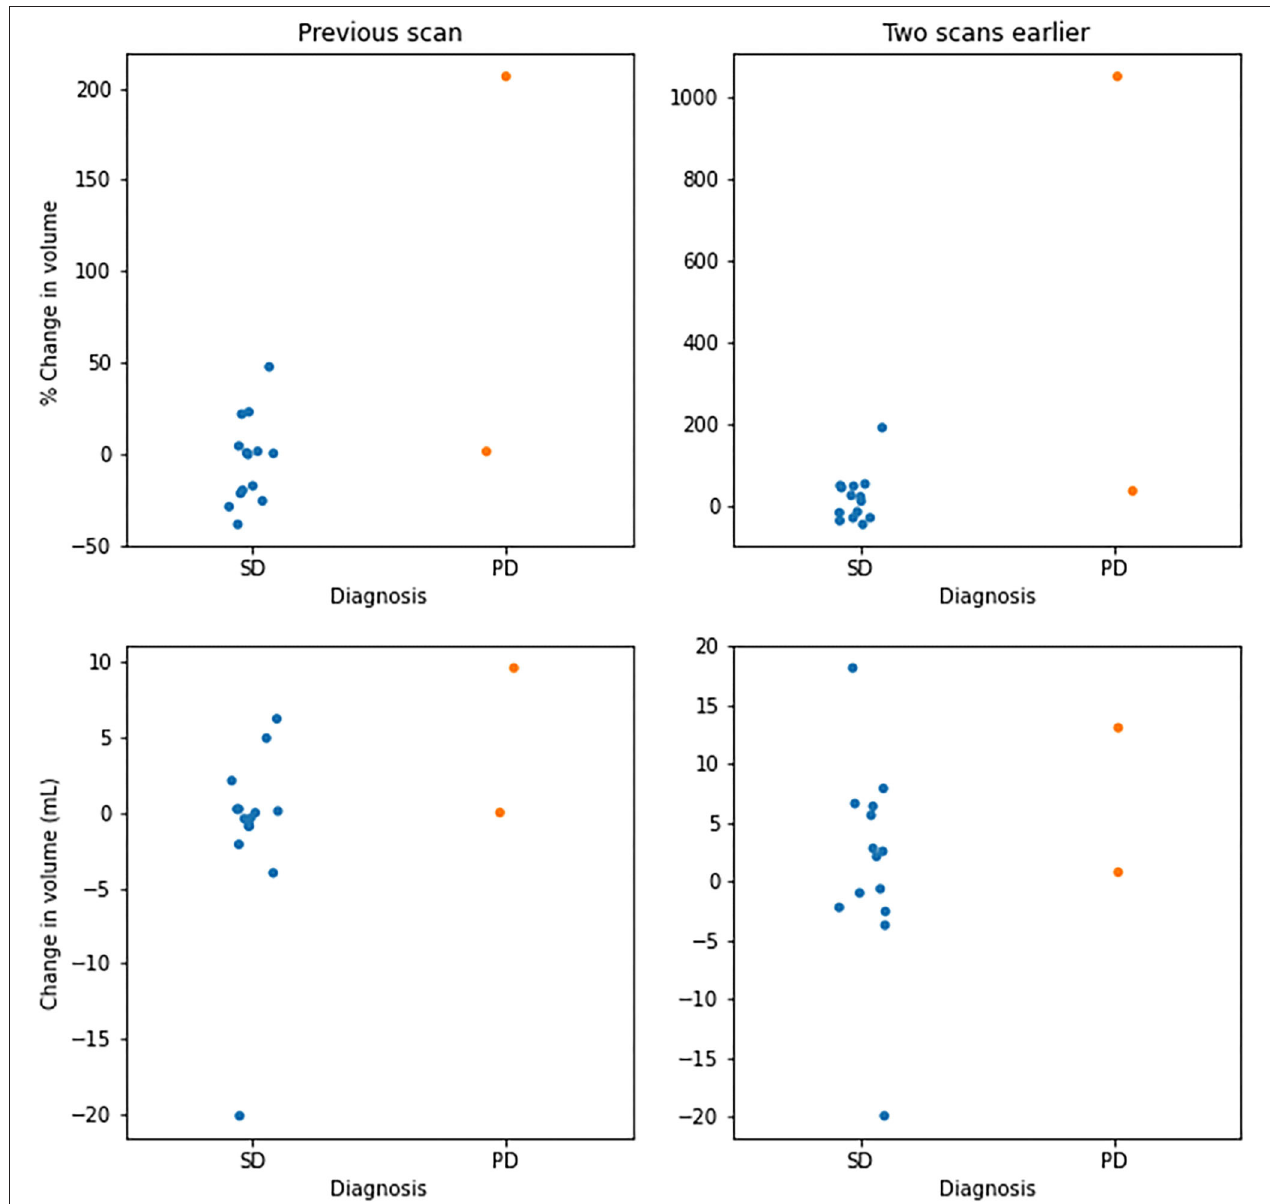
FIGURE 6 | Overview of volume changes in successful volume-based diagnosis. Changes per patient with respect to the previous scan (left) and two scans earlier (right). Values are given in percentage change (top) and change in volume (bottom), separated by diagnoses categorized as stable disease (SD) and progressive disease